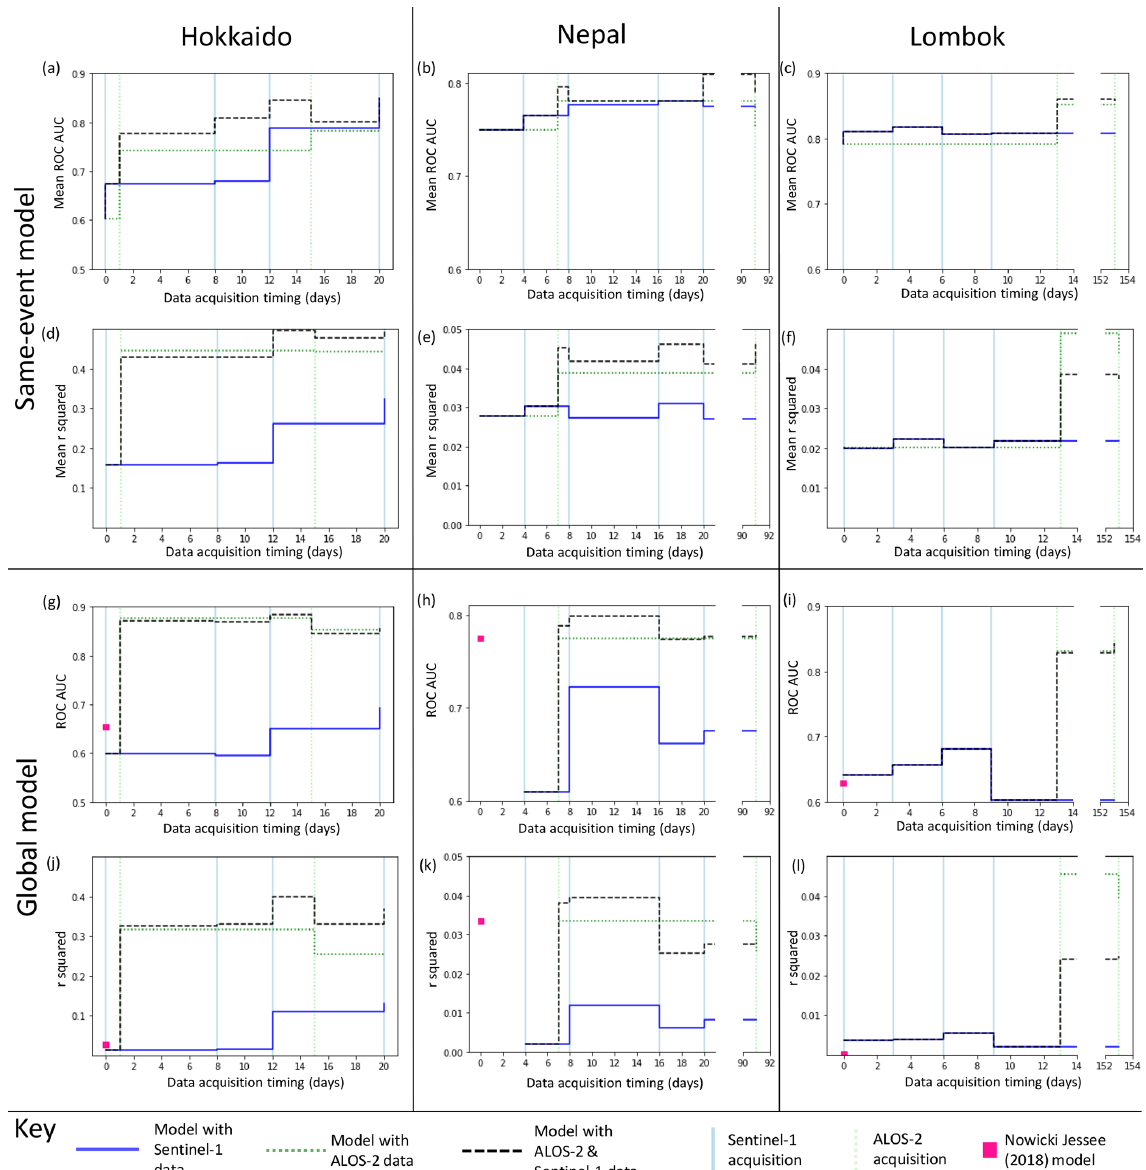
Figure 2. Step plots showing the change in ROC AUC (a–c, g–i) and r 2 (d–f, j–l) for each of the three events. Models in panels (a) – (f) were trained on a small part of each study area, while in panels (g) – (l) landslide areal density was predicted using a model trained on the other two case study regions in each